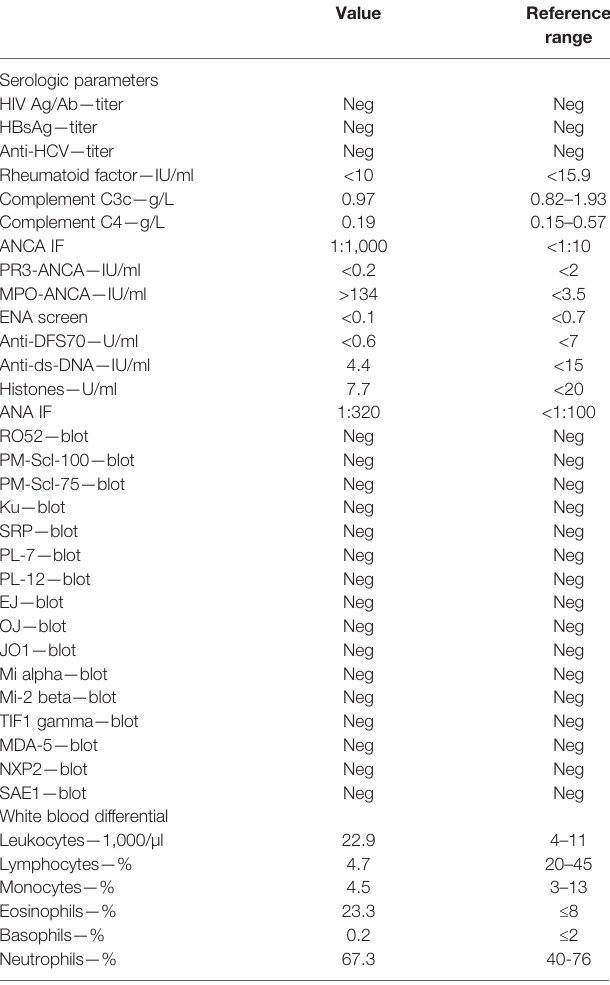
TABLE 1 | Serologic parameters after